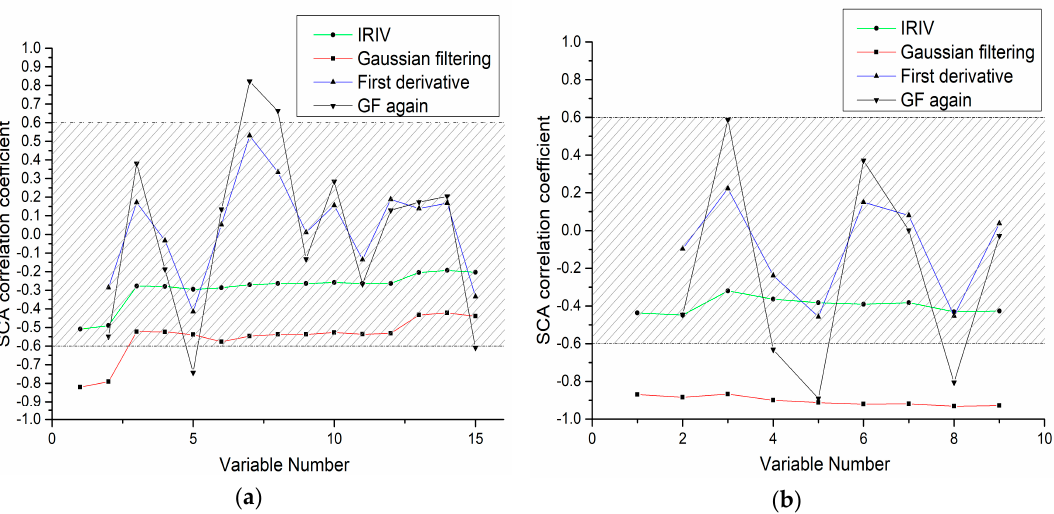
Figure 6. Correlation coe ffi cients between the di ff erent pretreatments and the As concentration of soil. The green line indicates the IRIV spectral reflectance and the As concentration of soil, the red line indicates the Gaussian filtering (GF) spectral reflectance and the As concentration of soil, the blue line indicates the first derivative (FD) spectral reflectance and the As concentration of soil, and the black line indicates the GFA spectral reflectance and the As concentration of soil ( a ) Laboratory spectra of the soil samples; ( b ) Field spectra of the soil samples. Table 3. The feature bands and the correlation coefficients.